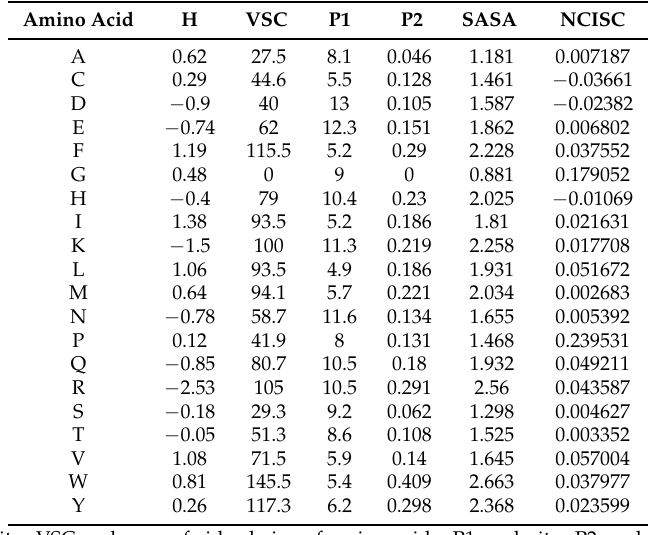
Table 6. Six physicochemical properties of 20 amino acid